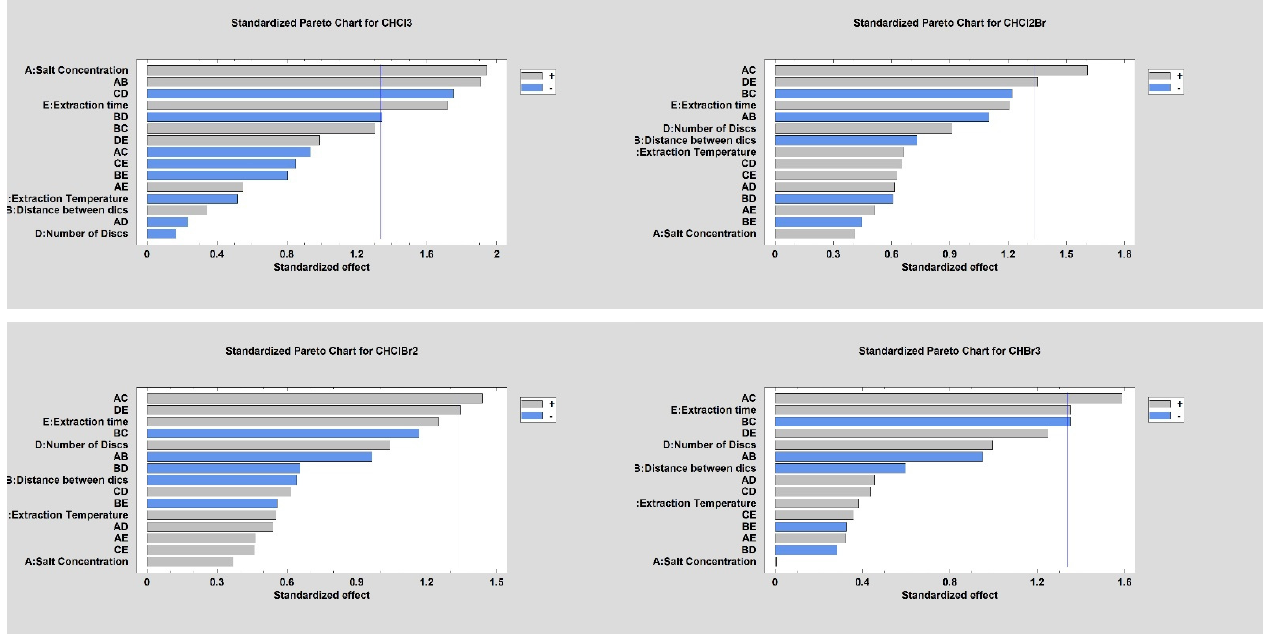
Figure 6. Pareto graphs for the optimization of THM analysis from water sample extraction by HS-SPME.